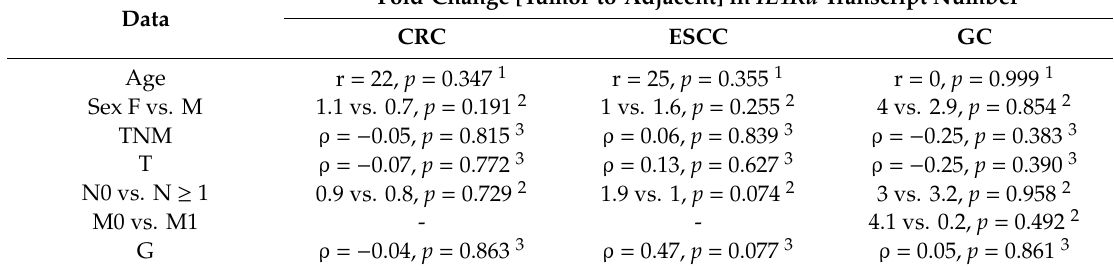
Table 5. Association of demographic and pathological data with IL4Ra mRNA expression in the GIT cancer